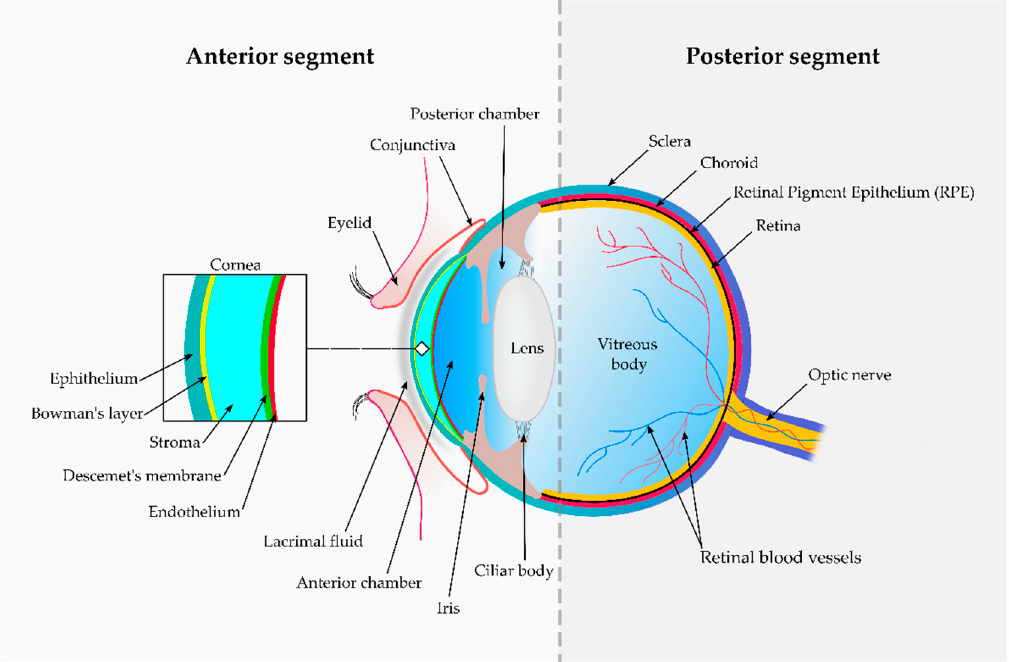
Figure 1. Schematic representation of the ocular anatomy. An imaginary line (dotted grey vertical line) divides the ocular structures into two segments. The anterior segment contains the cornea (detailed within the insert), iris, ciliary body and both anterior and posterior chambers. The aqueous humour fills the anterior and posterior chambers, while most of the posterior segment is filled by a hyaluronan-rich gel known as vitreous humour. The posterior segment also contains the sclera, similar in composition to the corneal stroma. The choroid is a highly vascularised tissue separated from the retina (neural tissue) by a monolayer of hexagonal pigment-containing cells: the retinal pigment epithelium.